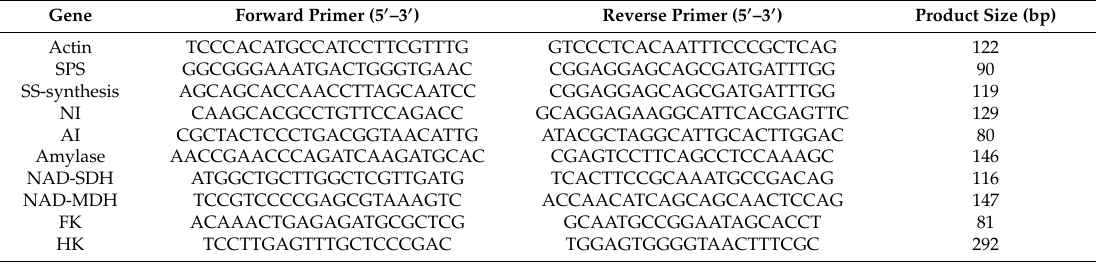
Table 1. Primer sequences used for real-time quantitative PCR